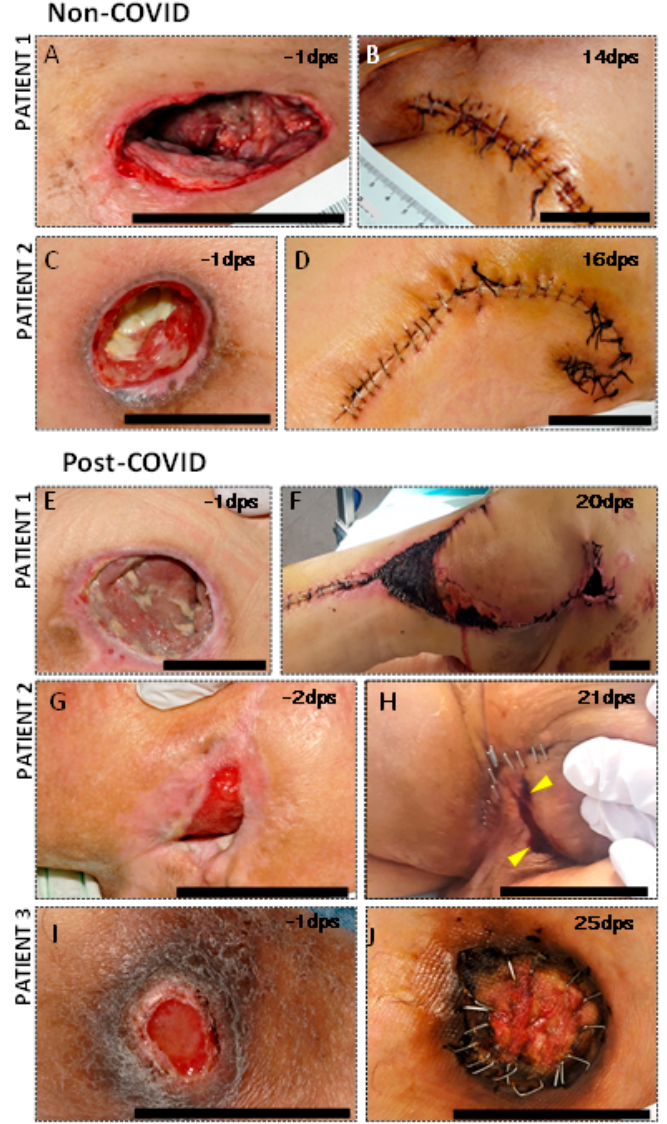
Figure 1. Pressure ulcers of non-COVID-19 and post-COVID-19 patients ( A , C , E , G , I ) and their evolu- tion several days after undergoing surgery. DPS: days post-surgery. Note the worse appearance of all wounds in individuals who had suffered SARS-CoV-2 ( E – J ) compared to those who had not ( A – D ), including the presence of postsurgical hematomas ( F ), eschars, and necrotic areas ( F , H , J ), increased dehiscence risk ( H , J ), serum-hematic exudate through the surgical wound ( H ), and significantly delayed healing ( F , H , J ). The yellow triangles mark hematic and purulent exudate. Scale bar 5